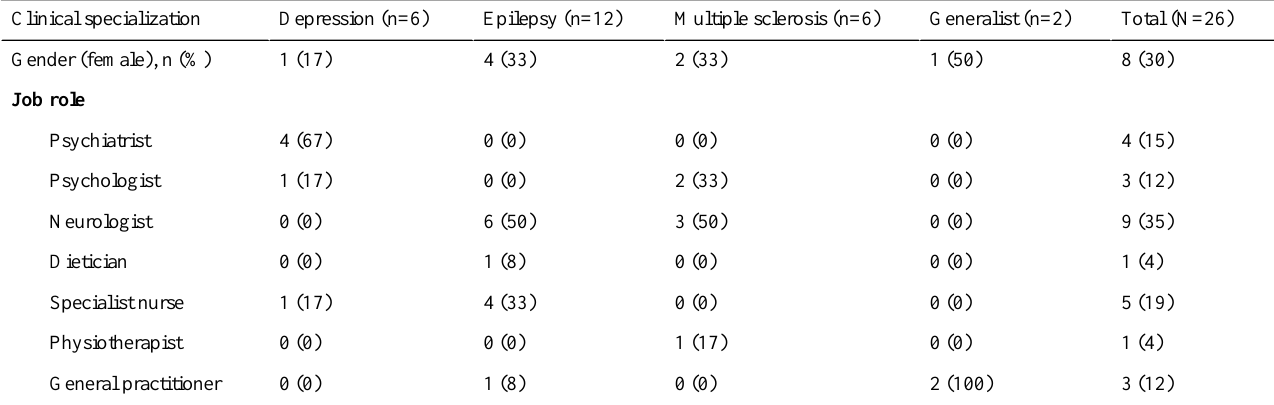
Table 1. Job roles, genders, and specializations of interview participants.